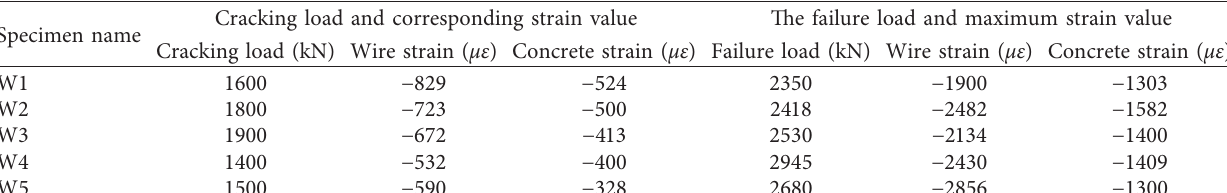
Table 3: Characteristic point data of comparison specimen.